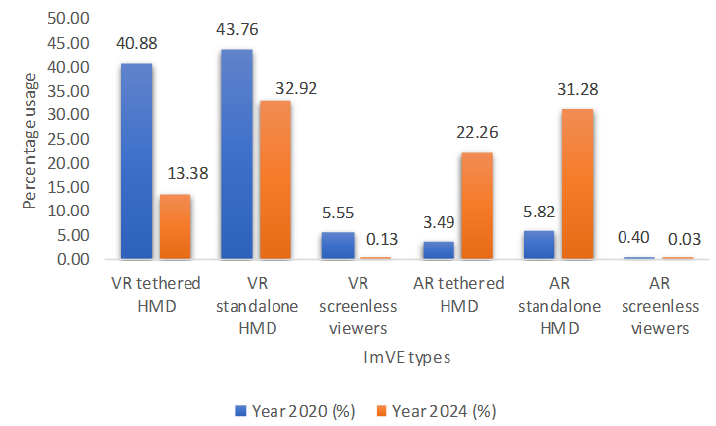
Figure 4. Main ImVE types and their usage comparison (Source: Statista).